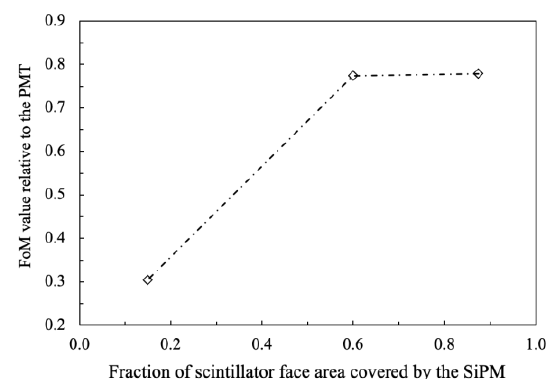
Fig. 11. Relationship between the performance of the detector assembly, in terms of n/  discrimination, as a function of the fraction of the scintillator face area covered by the